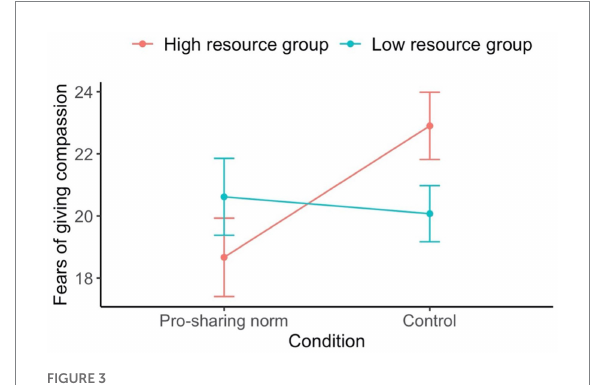
FIGURE 3 Average fears of giving compassion per condition and resource group for Study 3. Higher values indicate greater fears of giving compassion. Error bars represent standard